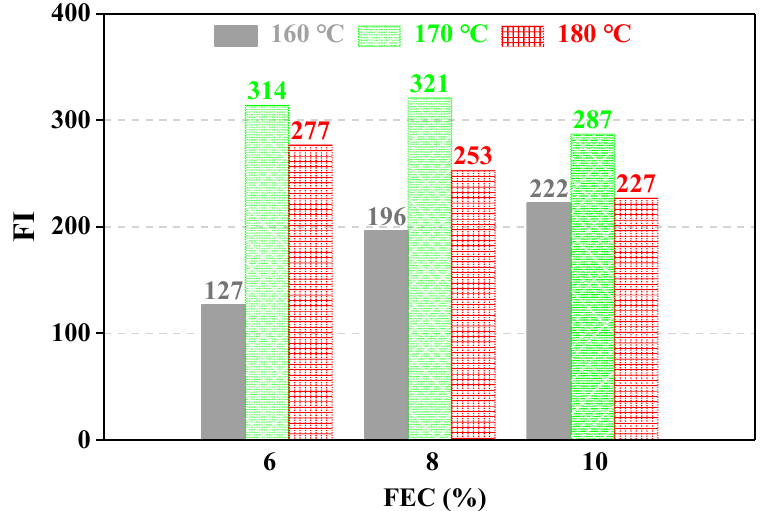
Figure 3. Relationship between FEC and FI at three temperatures.